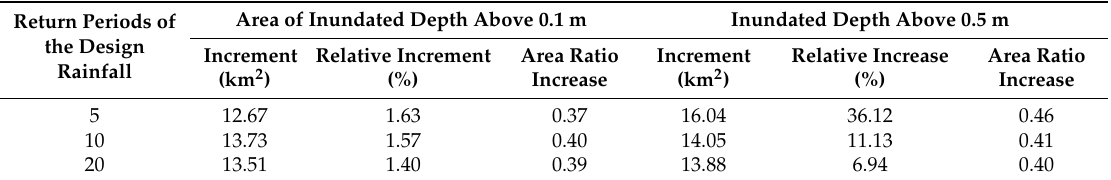
Table 5. The increment of the waterlogging area as the lake water level rises from condition 1 (cid:13) to condition 2 (cid:13) .